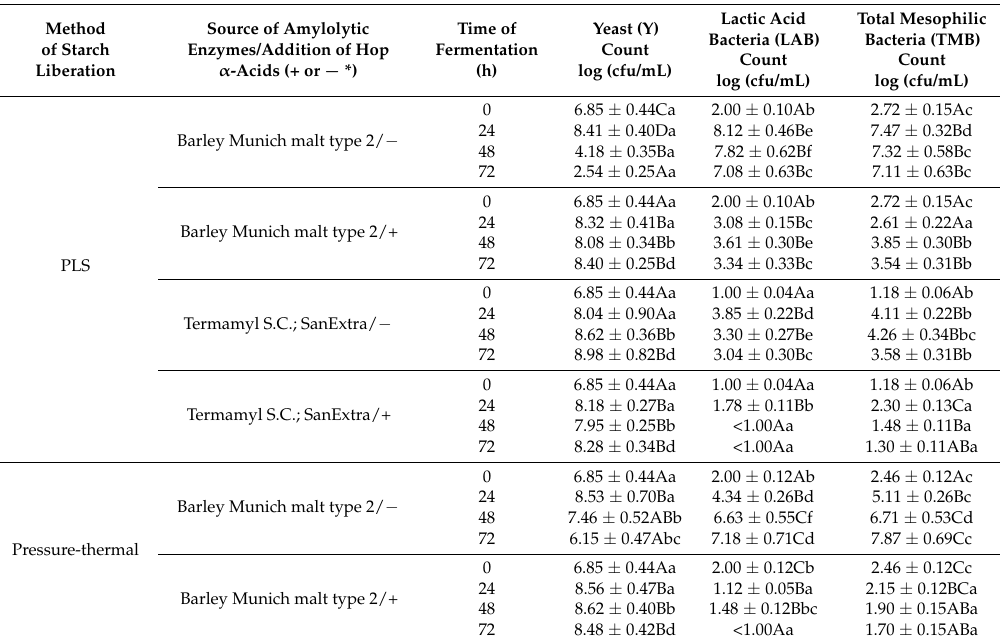
Table 4. Microbiological analysis of